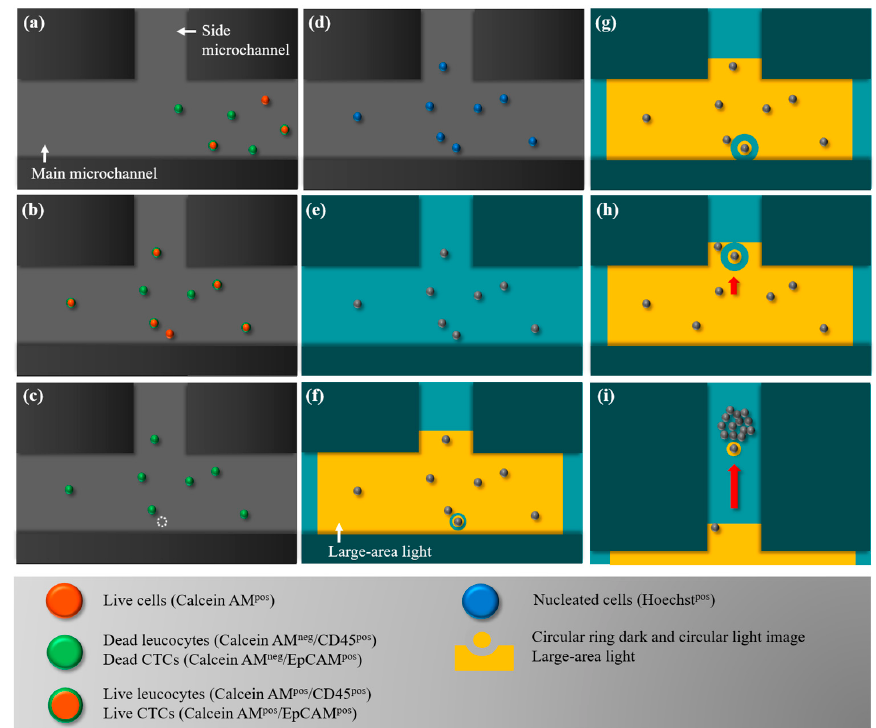
Figure 2. Schematic illustration of the overall working procedures for the isolation of EpCAM neg and CD45 neg cells: ( a ) Fluorescence microscopic observation was performed at the defined cell isolation